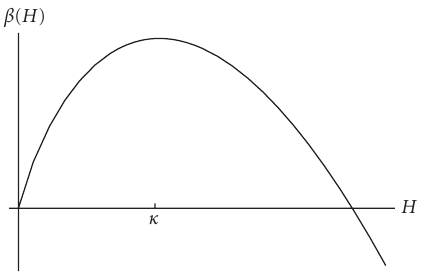
Figure 2.2. The function β ( H ) = ( σ 2 / 2)(1 − µH 1 / 3 ) H . Equation (2.19) is parabolic for H = S Γ < κ = (3 / (4 µ )) 3